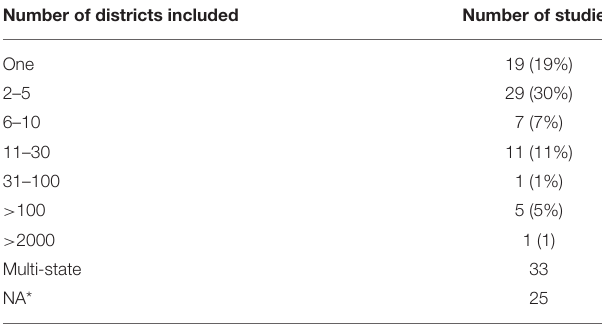
TABLE 4 | Sample Size of the